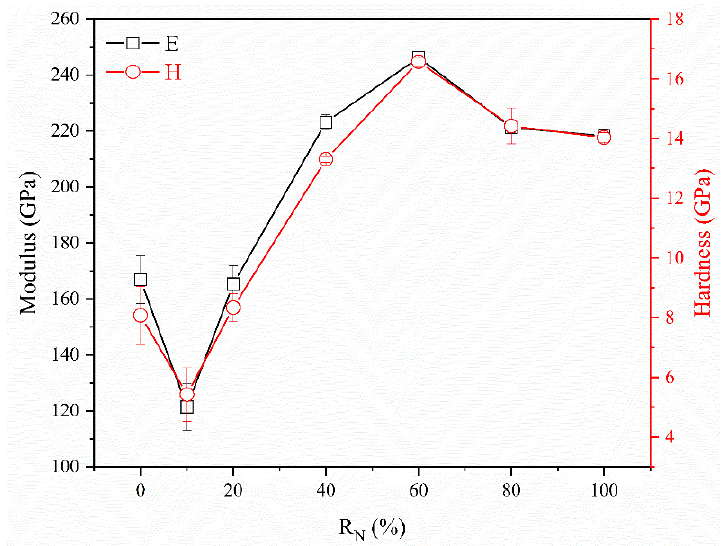
Figure 8. Modulus and hardness of (CrHfNbTaTiVZr)N coatings deposited at various R N .